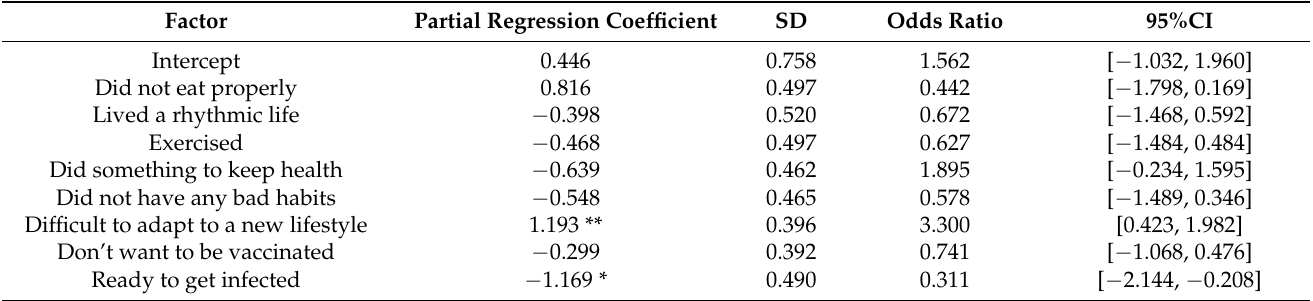
Table 7. Binormal regression of the responses to the question “Has the pandemic changed your self-assessment of health status?” (Khabarovsk boys).